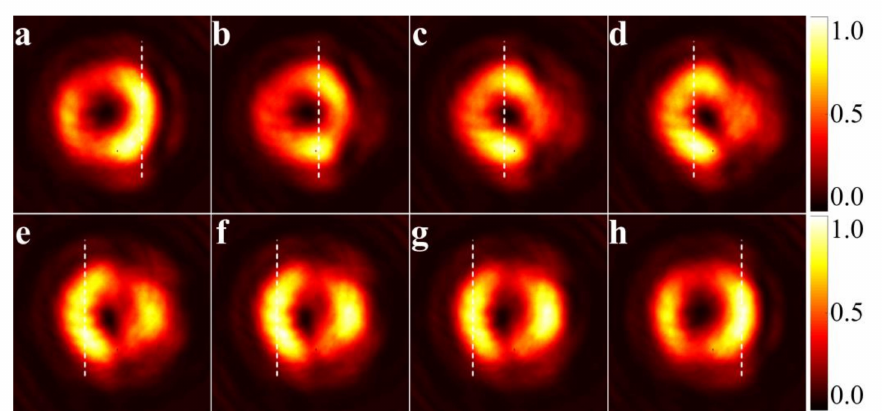
Figure 4. Experimentally measured Goos-Hänchen shift of a vortex beam with unit topological charge. The white dashed lines mark out the positions of the pattern peak, which shift continuously from left to right as the incident angle increases. Each figure is normalized to its maximal value to illustrate further detail.